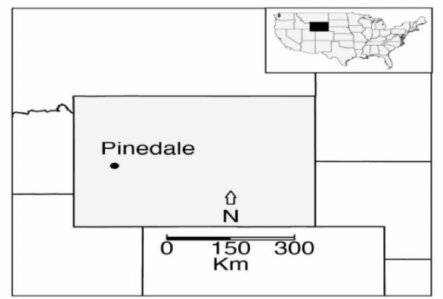
Figure 1. A location map showing where the Pinedale Anticline natural gas field lies within Wyoming, USA. A detailed map of the gas field can be found using the Pinedale Anticline Data Management System found at https://my.usgs.gov/papo/home (accessed on 30 March 2022). All sites were selected within the same ESD in an effort to reduce effects of different reference communities on reclaimed sites. Additionally, all sites were at least 0.8 km to the next closest location in this study, with some locations being up to 10 km apart. In both 2015 and 2016, 8 well pads were selected with 4 consisting of mass flowering Rocky Mountain example of the site types). Sites were inconsistent across years, as vegetation communities on reclaimed sites did not remain entirely consistent.